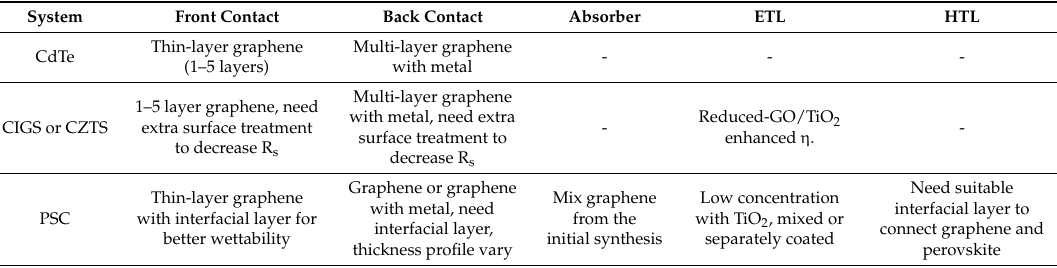
Table 5. Findings and suggestions of graphene application on thin film solar